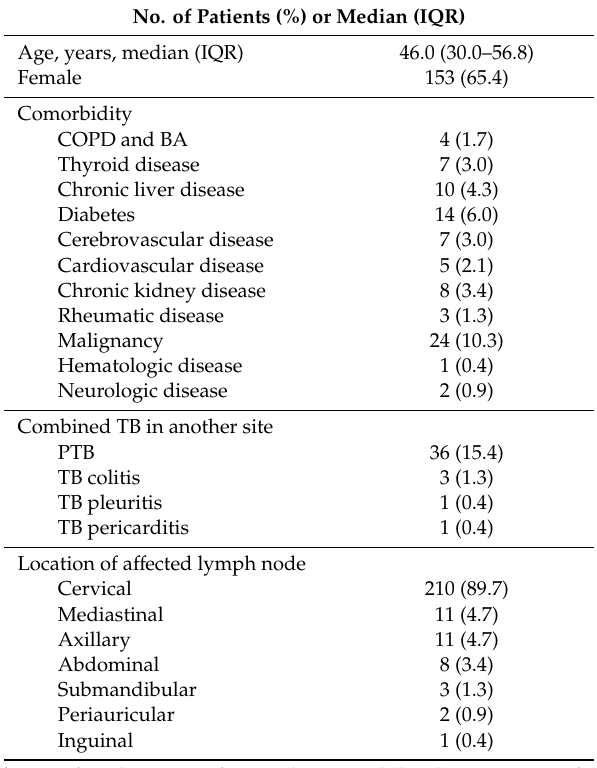
Figure 1. Flowchart of the study. TB, tuberculosis; HIV, human immune-deficiency virus; MDR, multi-drug resistant; DST, drug resistant test. Table 1. Demographic and clinical characteristics of 234 patients with tuberculous lymphadenitis (TBL).